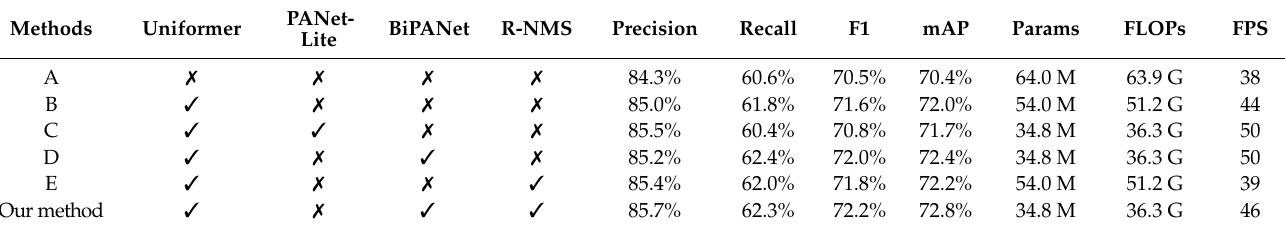
Table 6. Experimental results of different methods on the